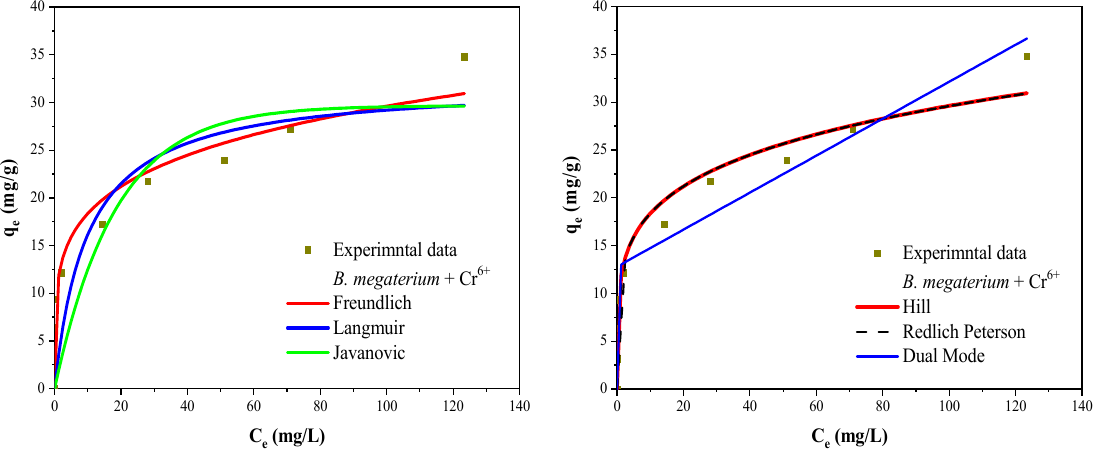
Figure 8. Graphical representation of adsorption isotherms applied to experimental data of Cr 6+ biosorption by Bacillus megaterium inactive biomass.